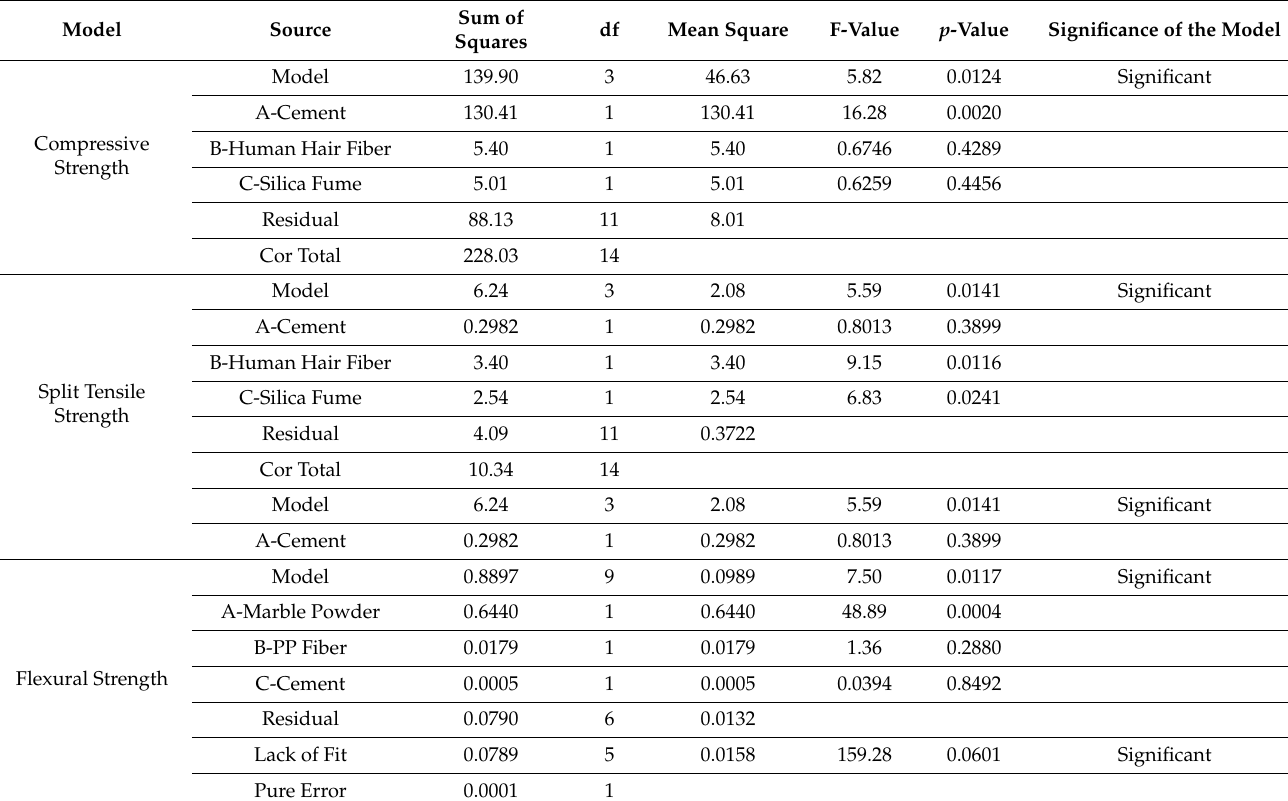
Table 6. ANOVA Analysis of the Response Models.